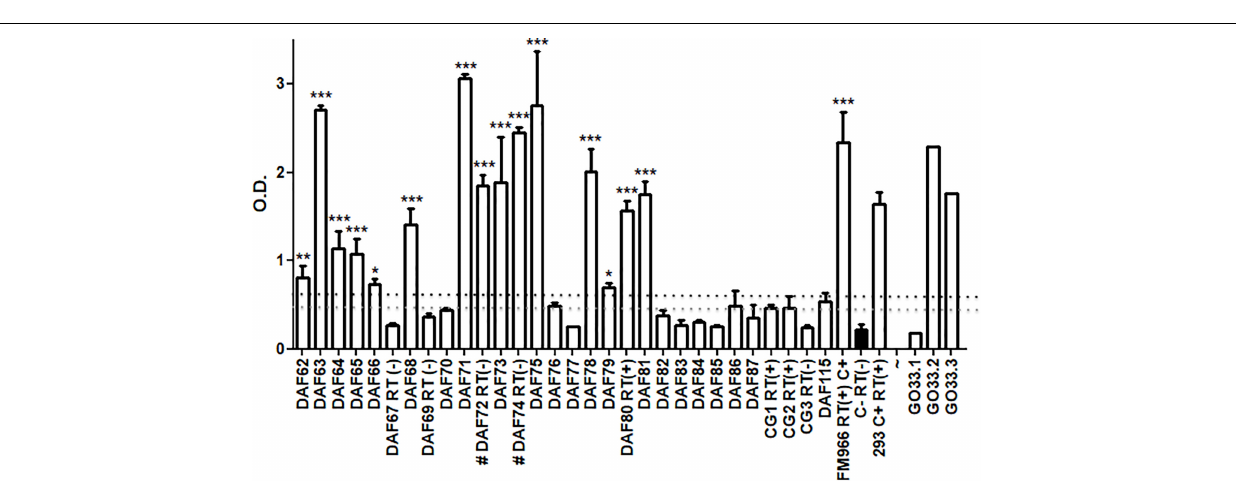
Frontiers in Plant Science |